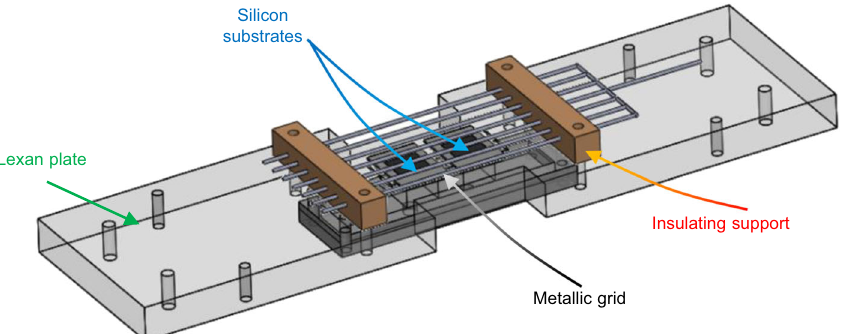
Fig. 7 3D CAD model of the test section. The silicon substrates are fi xed on a Lexan plate that is kept in the middle of the test cell fi lled with liquid FC-72. The steel grid is placed above the boiling region with supports of insulating material. a